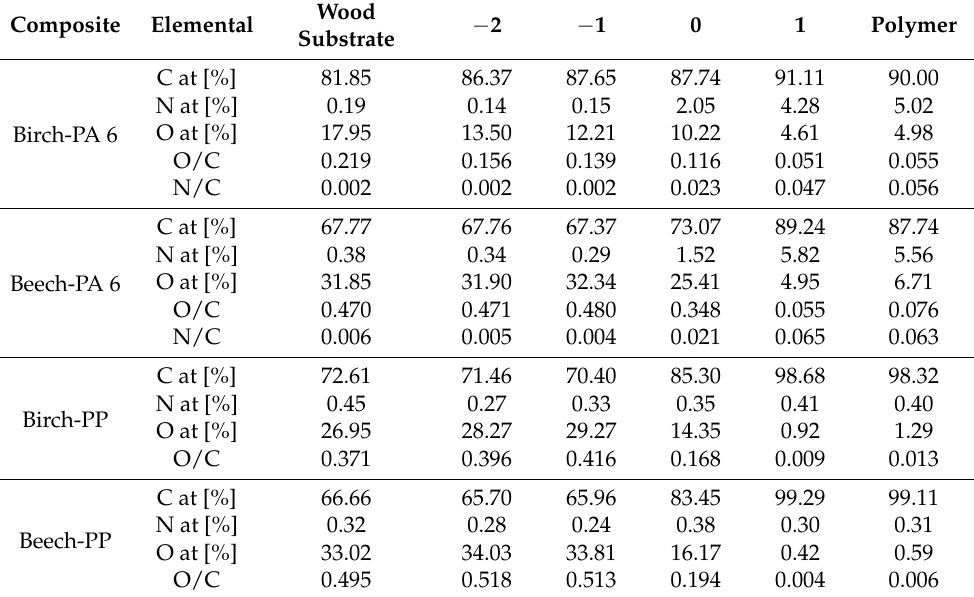
Table 1. Elemental composition of C, N and O over the sample cross-section for birch and beech solid wood overmolded with PA 6 and PP from XPS analysis. The position of the measuring spots placed on the samples are shown in Figure 4. In addition, the atomic O/C and N/C ratios determined by XPS analysis are